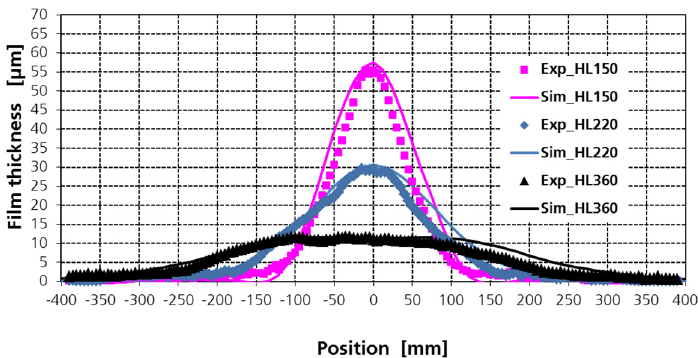
Figure 8. Comparison of measured and calculated dynamic film thickness distributions for three shaping air flow rates: 150, 220, 360 L/min.